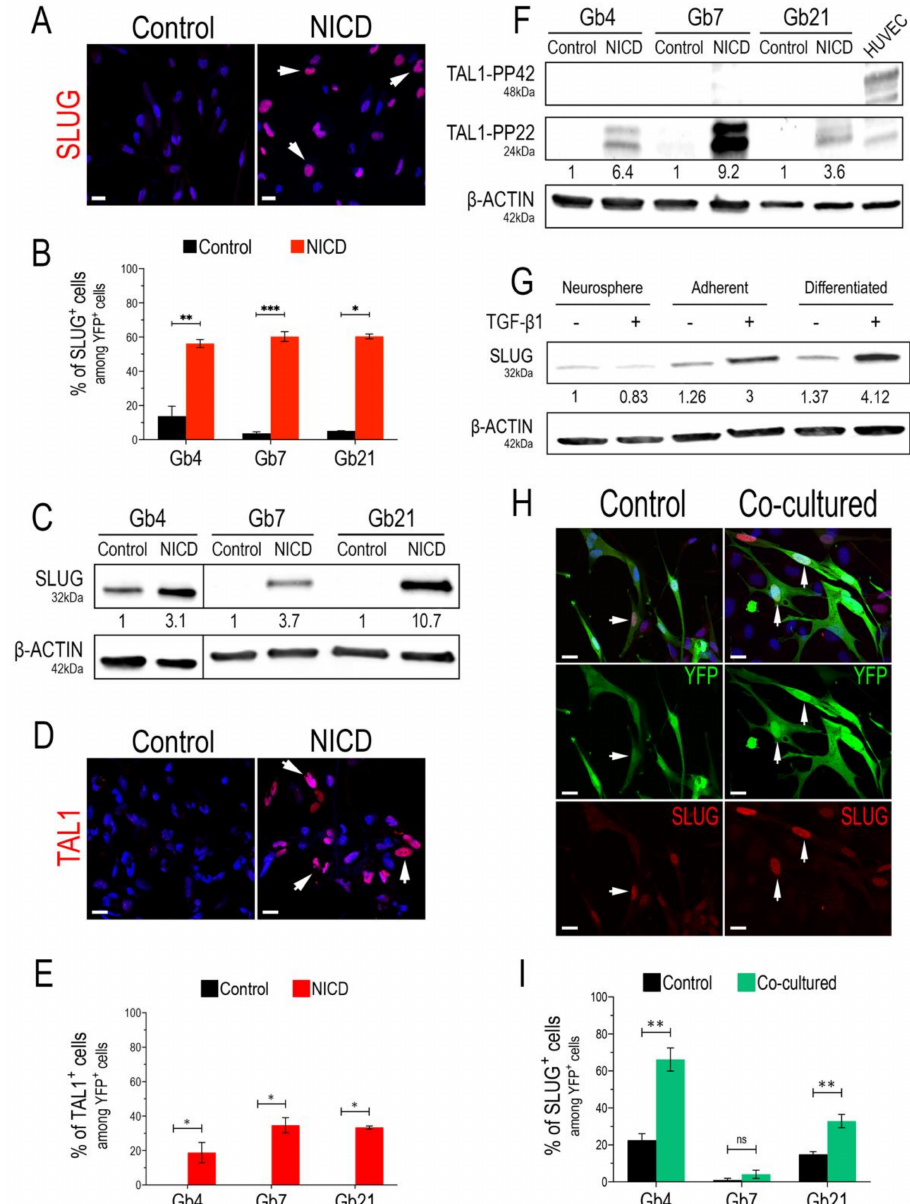
Figure 1. SLUG and TAL1 expression in cultured GSCs. ( A , D ) Representative IF images showing SLUG upregulation in Gb4 ( A ) and TAL1 induction ( D ) in Gb7 upon the transduction of the Notch1 IntraCellular Domain (NICD) in pro- liferating adherent conditions (PDL/Laminin). Arrowheads indicate positive cells; scales 20 µ m. ( B , E ) Quantification of SLUG + /TAL1 + cells following Notch1 activation in Gb4, Gb7, and Gb21 cells. ( C , F ) Representative WB images and quantifications showing SLUG upregulation ( C ) and TAL1-PP22 induction ( F ) in Gb4, Gb7, and Gb21 cells upon NICD transduction ( n = 3, Figure S9A,B). ( C ) The original image was modified so that the Gb4 lanes appear on the left. ( G ) SLUG expression and upregulation in Gb4 cells using different culture methods; including proliferating neurospheres, adherent proliferating, and adherent differentiating conditions; with (+) or without ( − ) TGB- β 1 treatment (2 ng/mL). Cells were harvested after 5 days of culture and/or treatment. Proliferating neurosphere conditions without TGB- β 1 treatment were used as the basal condition for quantifications ( n = 3, Figure S9C). ( H ) Representative IF images of SLUG upregulation in Gb4 cells upon co-culture with HUVEC endothelial cells. Cells were cocultured for 72 h and transduced with a YFP lentivirus in order to discriminate them from HUVEC cells. Arrowheads indicate YFP + Gb4 GSCs. scales 20 µ m. ( I ) Quan- tification of YFP + SLUG + Gb4, Gb7, and Gb21 cells after co-culture with HUVEC cells (72 h). ( B , E , I ) Statistical analyses using rank Mann–Whitney tests, n = 3, ≥ 150 YFP + cells quantified per experiment, ***, p < 0.001; **, p < 0.01; *, p ≤ 0.05, n.s. = not